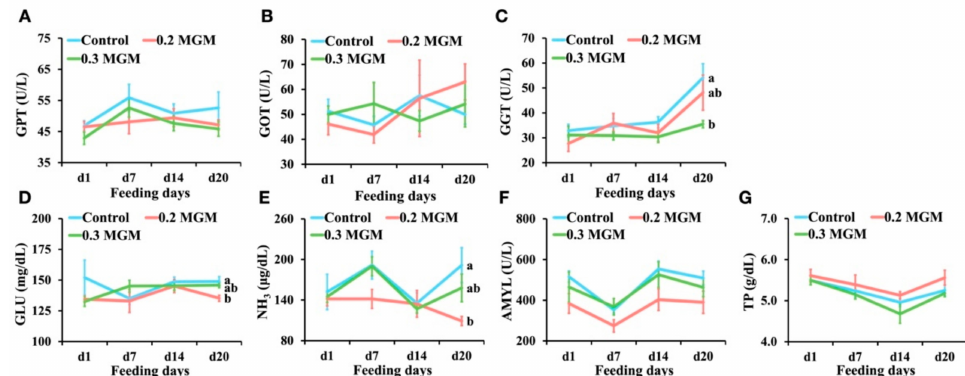
Figure 4. Effects of MGM-P supplementation on blood biochemical parameters of weaned piglets. Blood was collected on d1 before the provision of feed with MGM-P on the day of weaning. Values are expressed as mean ± SEM; n = 8. Different lowercase letters on the right side of the nodes indicate significant differences ( p < 0.05; Tukey HSD test). ( A ) the changes of the glutamic pyruvic transaminase level; ( B ) the changes of the glutamic oxaloacetic transaminase level; ( C ) the changes of the gamma glutamyl transferase level; ( D ) the changes of the glucose concentration; ( E ) the changes of the ammonia concentration; ( F ) the changes of the amylase level; ( G ) the changes of the total protein